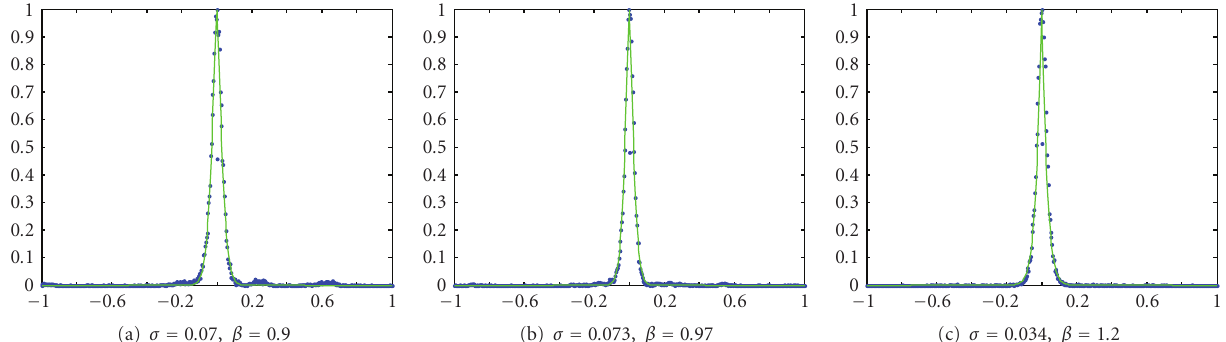
Figure 2: Example of the subband modeling of, respectively, the horizontal, the vertical, and the diagonal subbands (in blue the coe ffi cients distribution, in green the GGD with the given parameters).